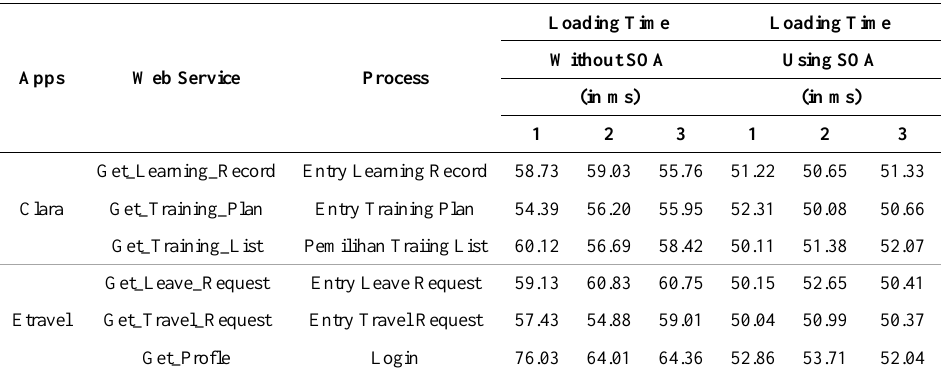
Table 5. Application Testing